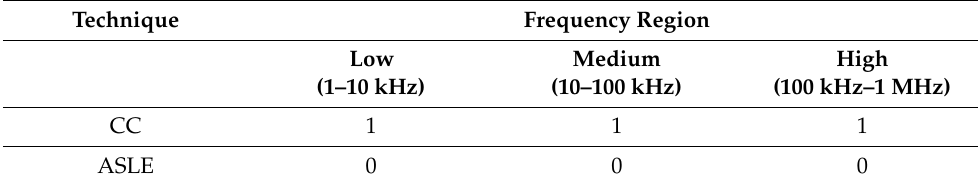
Table 3. Numerical technique for healthy winding